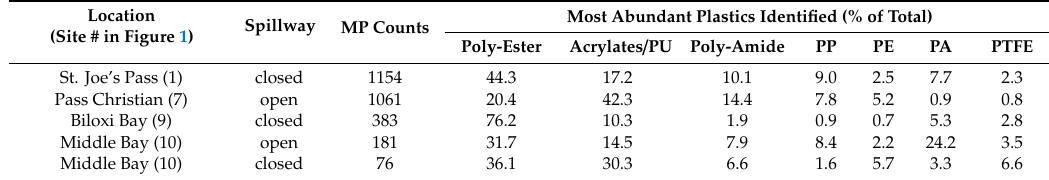
Table 3. Identification of microplastics in a subset of samples from the Mississippi Sound by LDIR.